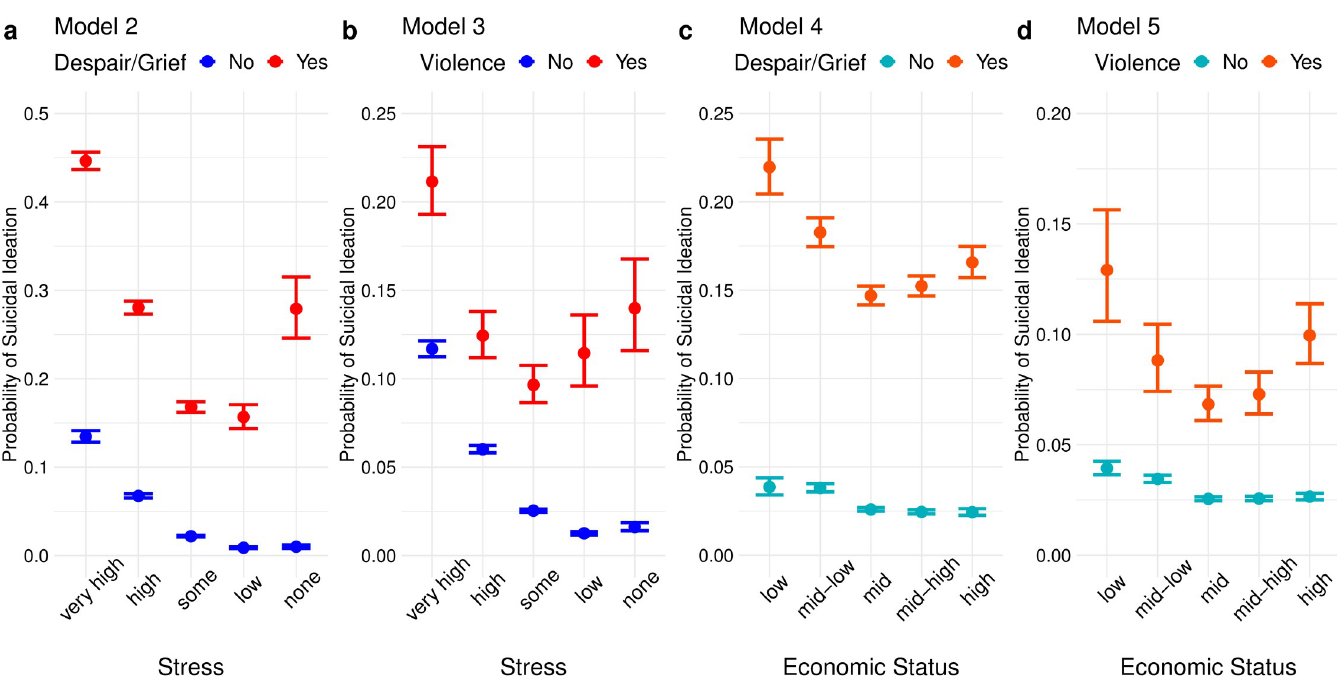
Fig 2. Predicted probabilities for each category of stress and economic status. All variables not involved in the interaction were set to zero or the reference category. Error bars indicate 90% confidence intervals.